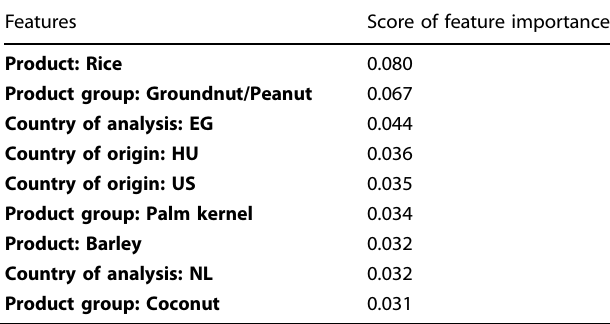
Table 3. Ten most important features of the selected ML model, with the features ranked based on their respective score, and the score representing the importance of an feature contributing to the construction of the XGB model.